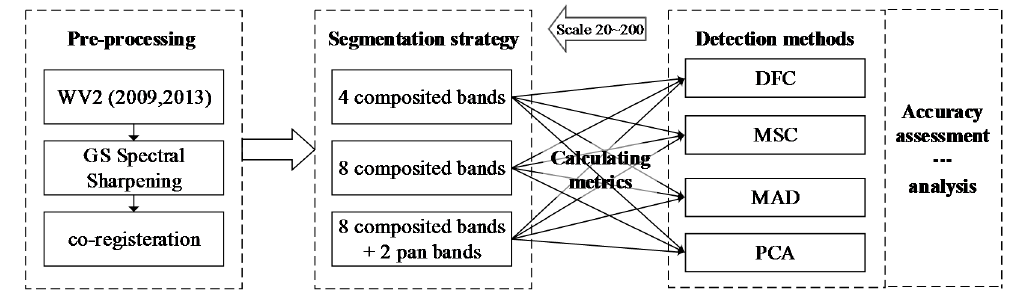
Figure 2. Change detection flowchart for a comprehensive assessment.